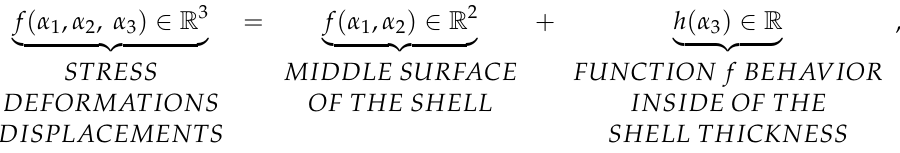
Figure 1. Mechanical model of tunnel ventilation shafts building by “floating shafts” construction system, ( a ) Analysis scheme for shafts, ( b ) Free body diagram of shaft differential slice